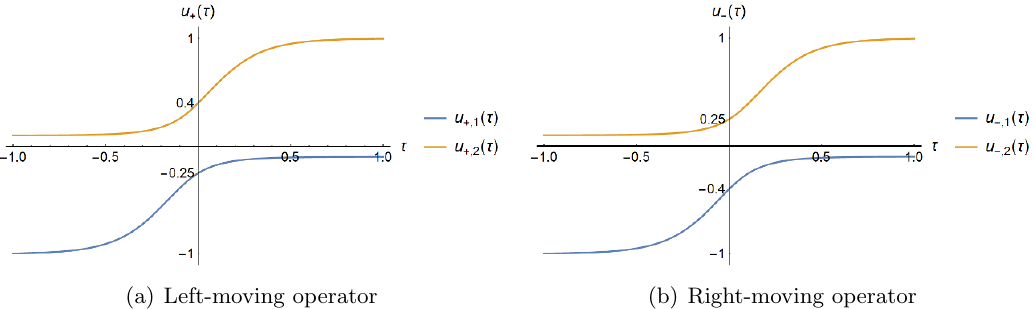
Figure 5 . The trajectories of the left-moving and right-moving operators during the (cid:13)ow in (cid:12)gure 4. Note that from the de(cid:12)nition of u (cid:6) in (2.16), u (cid:0) is larger at the left end-point, while u + is larger at the right end-point, thus under the modular (cid:13)ow in (cid:12)gure 4, the left-moving operator is pushed to the right, while the right-moving operator is pushed to the left. Also note that the regions 1 and 2 are also labeled oppositely for operators with di(cid:11)erent